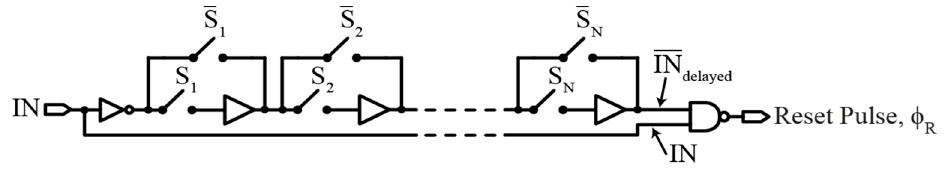
Figure 5. Simple Pulse-Width Generator (PWG) circuit.